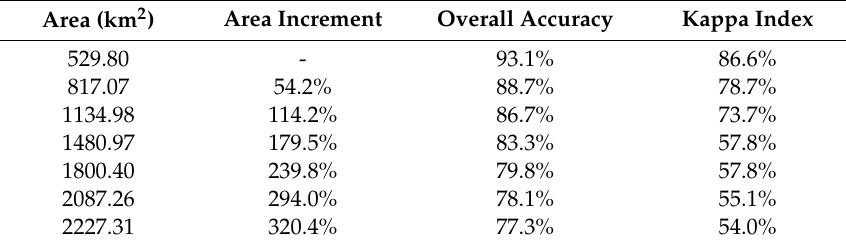
Table 7. Results of random forest (RF) classification trained with a non-random partial subset in relation to the RF trained with the complete study